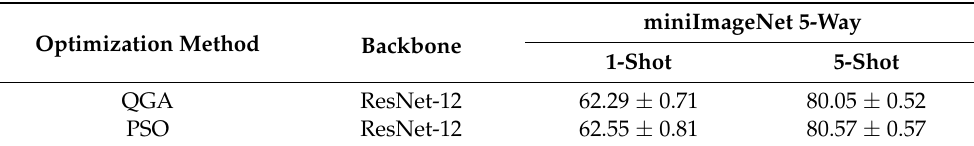
Table 9. Meta-learning accuracy of different optimization methods on miniImageNet. QGA denotes Quantum Genetic Algorithm. PSO stands for Particle Swarm Optimization.